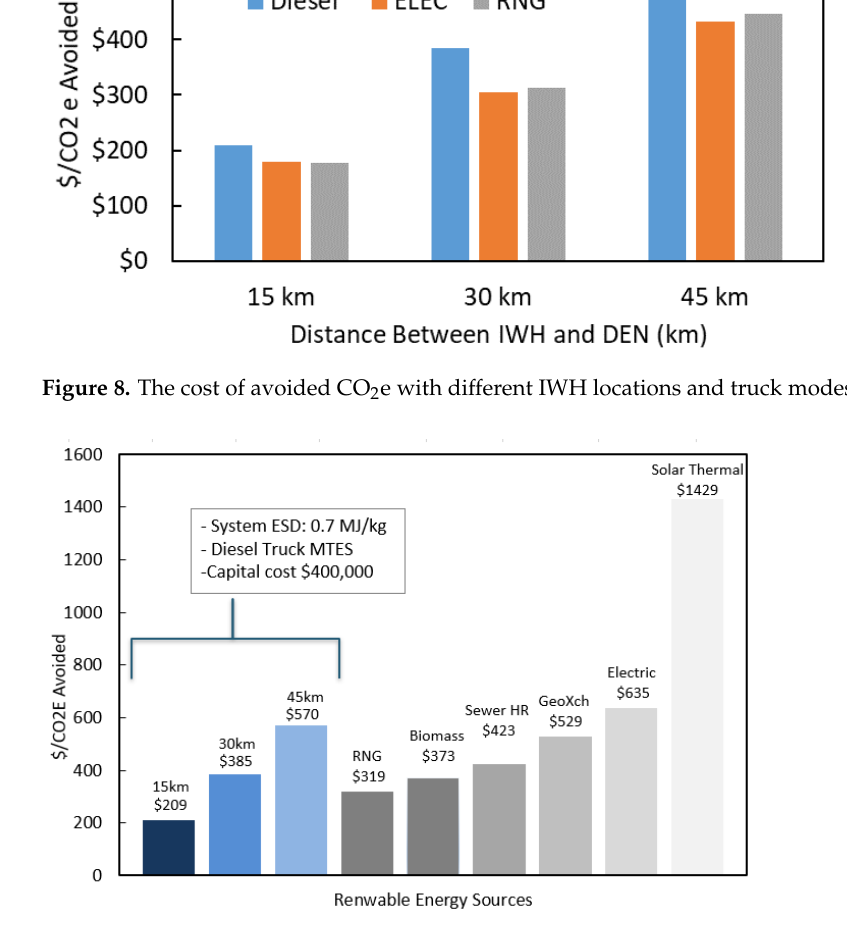
Figure 9. The avoided GHG Cost ($/tCO 2 e avoided) for diesel truck M-TES varies with the distance. Results are shown for the levelized cost estimation of M-TES with a system level ESD of 0.7 MJ/kg and other Surrey DEN low-carbon sources.